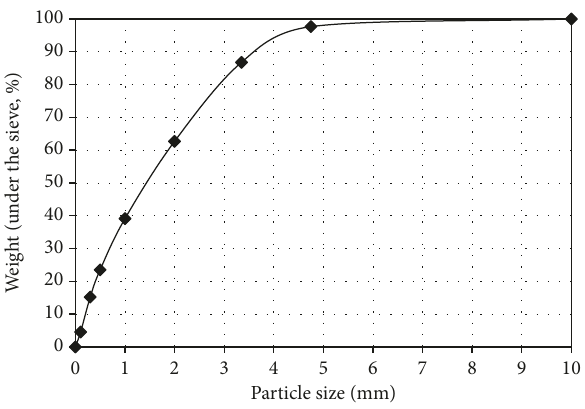
Figure 2: Sample-C1 coal screen analysis graphic.